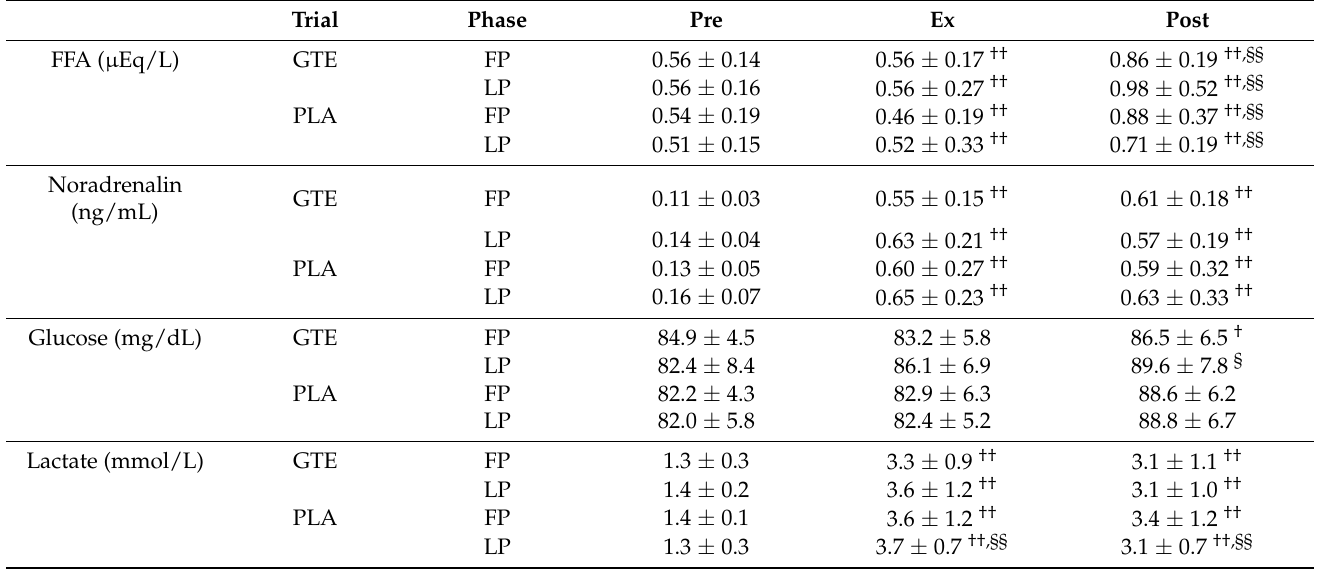
Table 2. FFA, noradrenalin, glucose, and lactate concentrations before, during, and after exercise. Trial